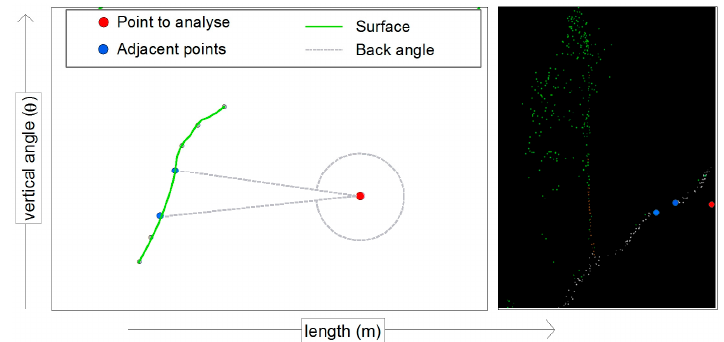
Figure 3. Terrain view from the side with measurement error.